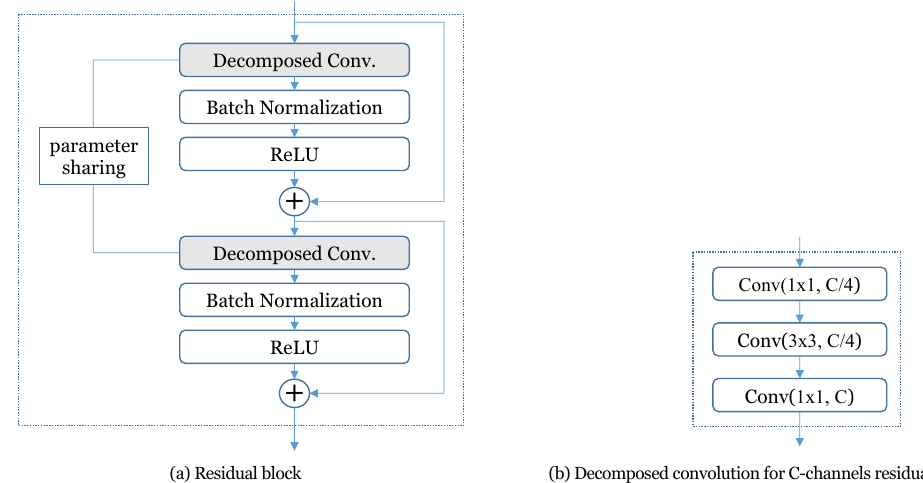
Figure 4. Block diagrams of ( a ) the residual block and ( b ) CP-decomposed convolution block in Table 1. C in ( b ) is the number of channels of the residual block.